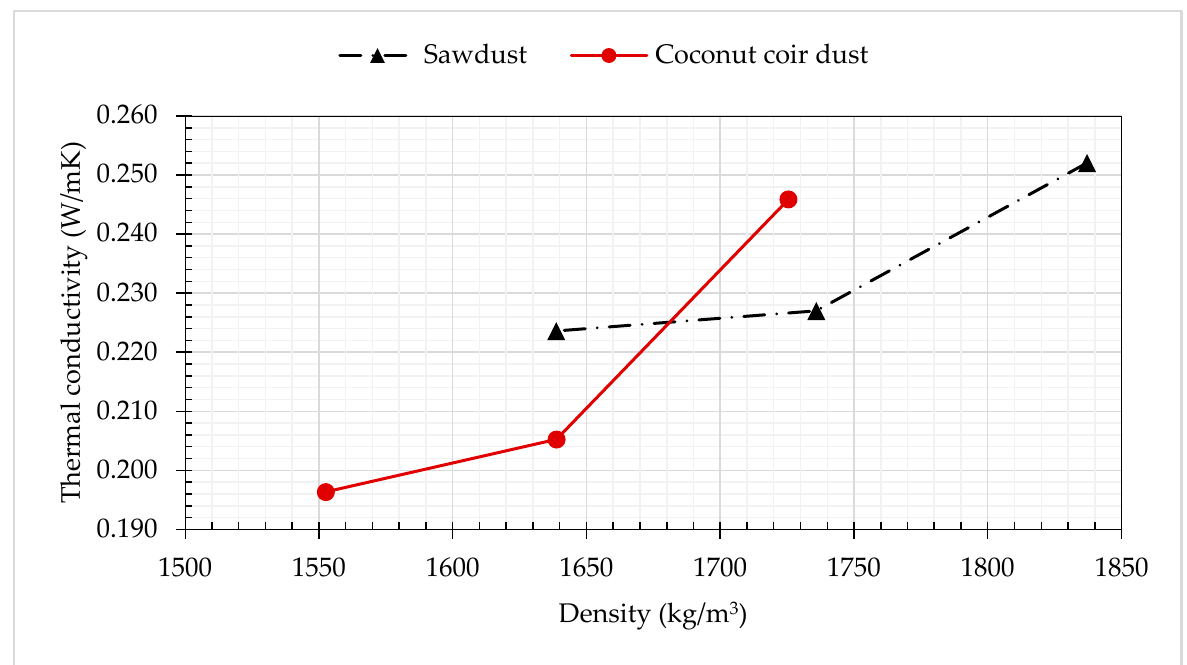
Figure 8. Correlation between thermal conductivity and density.